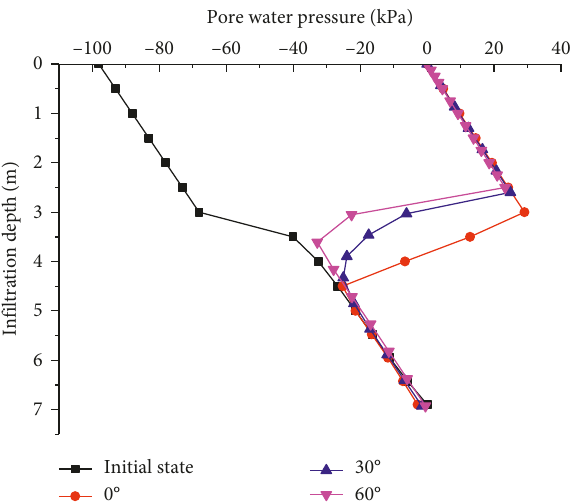
Figure 10: Distribution curves of pore water pressure with depth in different fracture angles (fracture depth 3 m).